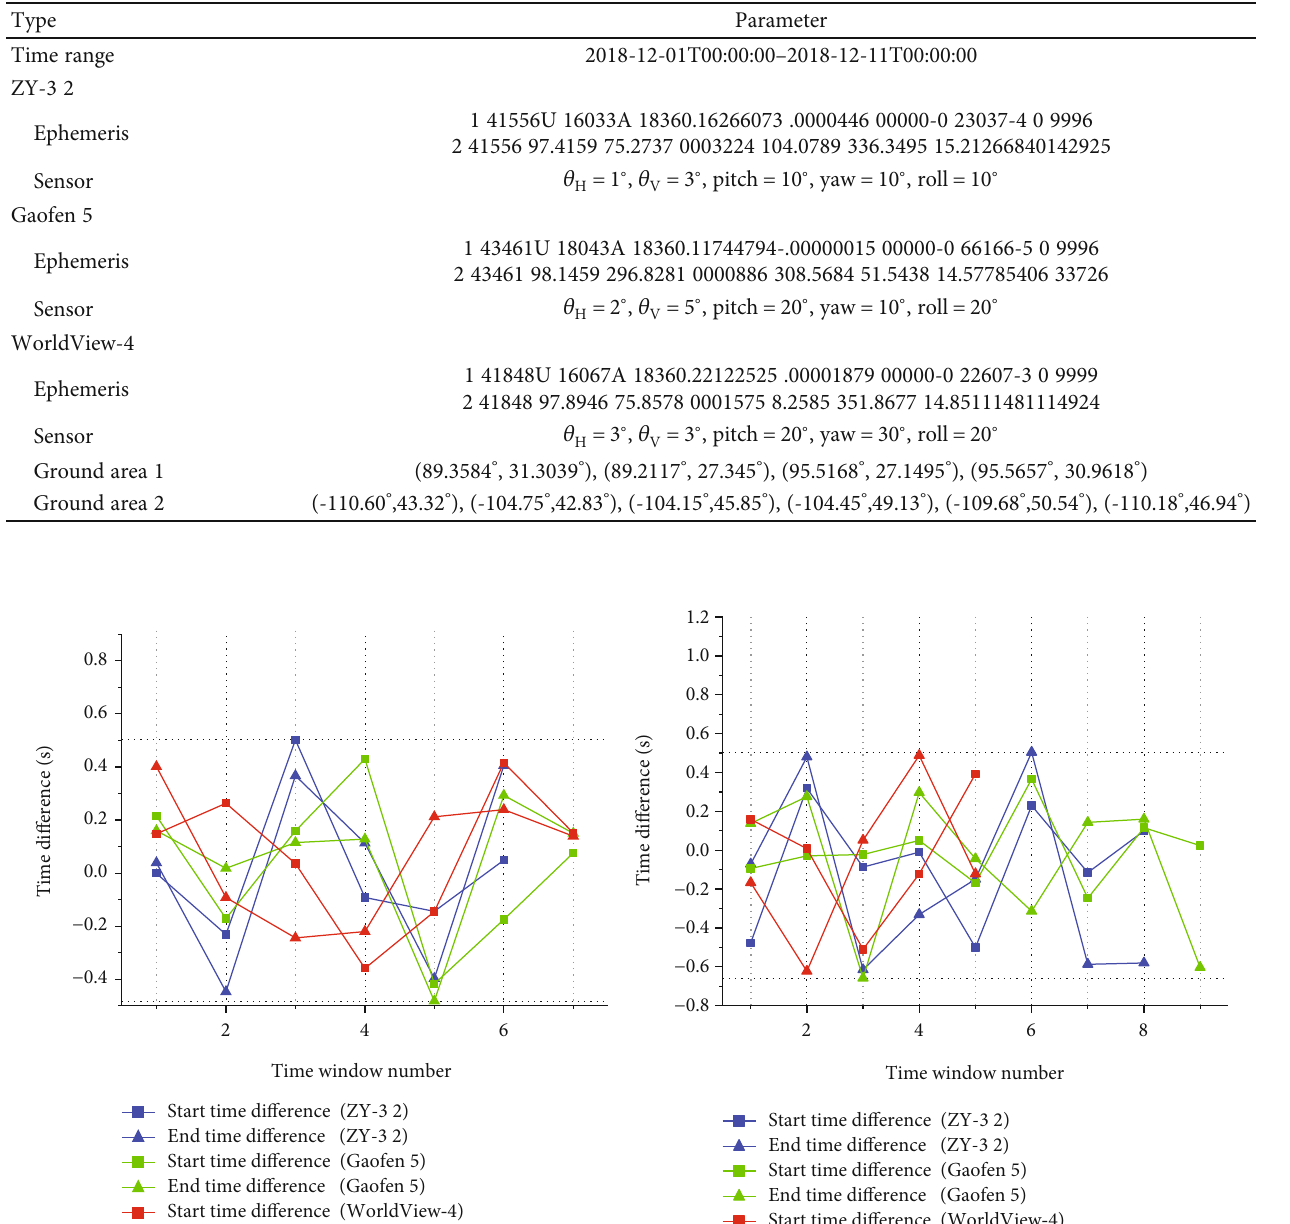
Table 3: Experiment dataset details.